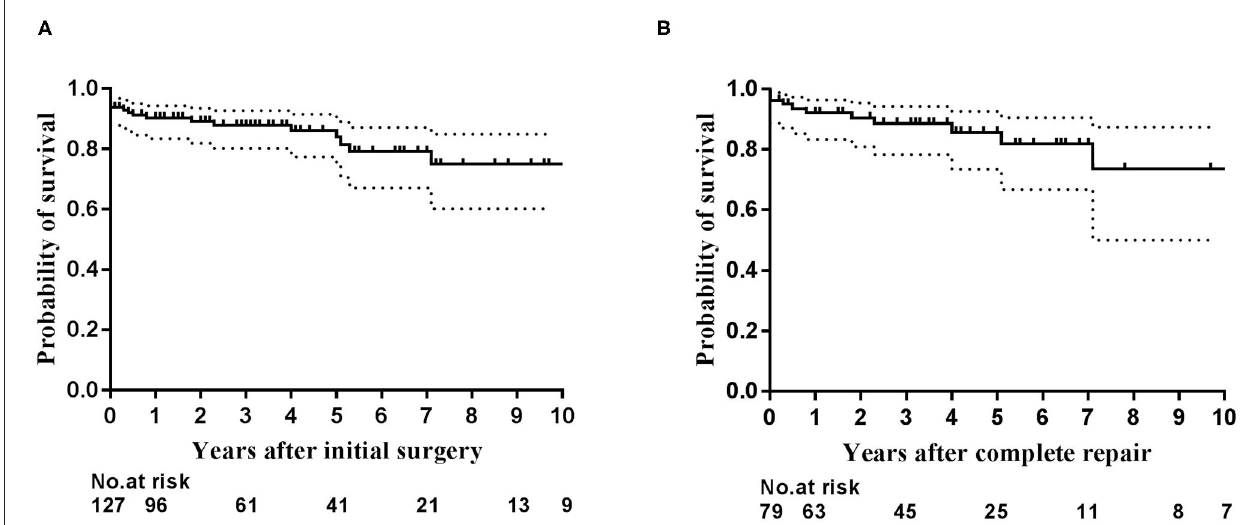
FIGURE 2 | The Kaplan–Meier curves depict estimated survival. (A) Survival for the entire cohort of 127 patients after initial operation; (B) Survival for patients after complete repair.